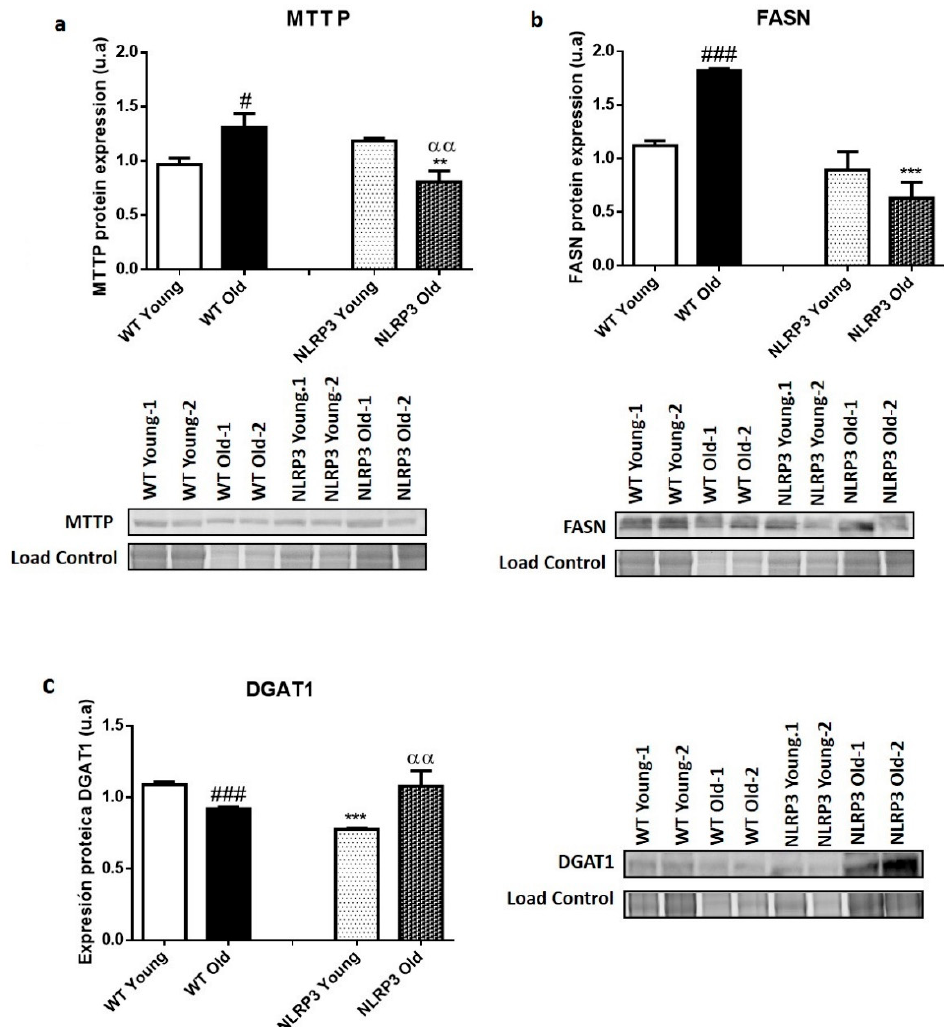
Figure 2. Protein expression levels of lipid metabolism markers in the liver tissue samples of WT and NLRP3 − / − mice. ( a ) MTTP ( b ) FASN ( c ) DGAT1. All data are shown as the means ± SEM ( n = 8). ** p ≤ 0.01/*** p ≤ 0.001 (WT Young/Old vs. NLRP3 Young/Old); # p ≤ 0.05/### p ≤ 0.001 (WT Young vs. WT old); αα p ≤ 0.01(NLRP3 Young vs. NLRP3 old).